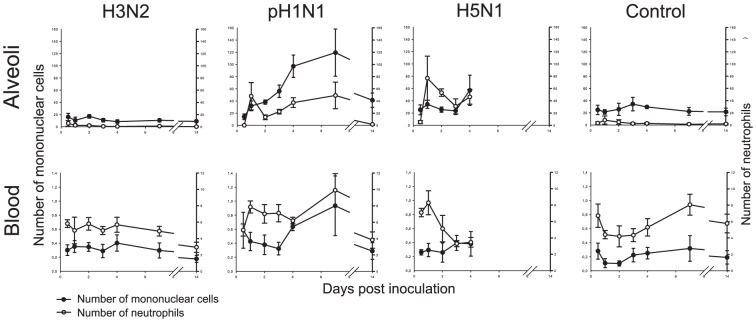
Leucocyte counts in alveoli and blood of ferrets inoculated with different influenza viruses.The number of leucocytes in the alveolar lumina (scores) and blood (×109/L) are depicted as median values and standard errors of the mean. The number of mononuclear cells and neutrophils in the alveolar lumina and blood follow the same pattern for H3N2 and pH1N1. The increase of the number of mononuclear cells in the alveoli and decrease in the blood for pH1N1 demonstrates the demand in the alveoli. For pH1N1 there is a peak of neutrophils in the alveoli on 0.5 dpi followed by a dip and a response of myelopoiesis in the blood. For H5N1 the number of mononuclear cells is not elevated in the alveoli and blood, and the high demand for neutrophils in the alveoli is not followed by higher release of neutrophils in the blood. In negative control animals (non-inoculated) the median number (range) of mononuclear cells is 0.30 109/L (0.13–0.37) in the blood and 17 (5–22) in the alveolar lumina, for neutrophils 4.33 (3.07–7.28) in the blood and 0.5 (0–2) in the alveolar lumina.